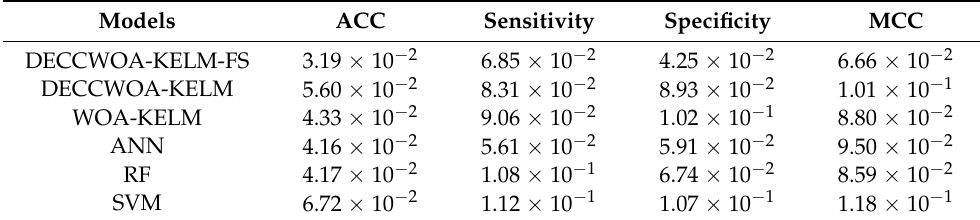
Table 8. Four std metrics results of the proposed model and other